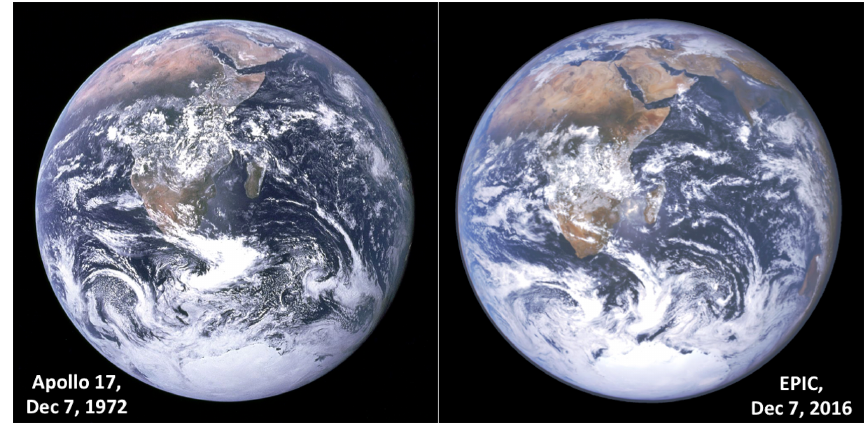
Figure 1. EPIC image (https://epic.gsfc.nasa.gov/?date=2016-12-07) of the entire sunlit Earth hemisphere (right) is compared with the Apollo (https://en.wikipedia.org/wiki/File:The_Earth_seen_from_Apollo_17.jpg) image taken on the same day 44 years ago. The two images show a remarkably similar large-scale cloud structure. (The EPIC image was recolorized to match the Apollo 17 image’s Kodak Ektachrome film by Karin Blank,